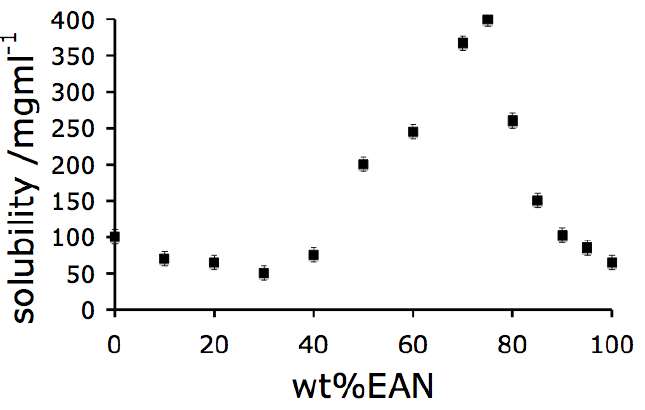
Figure 1. Solubility profile for Hen lysozyme in EAN/water mixtures, as determined using light scattering assessments of the solution